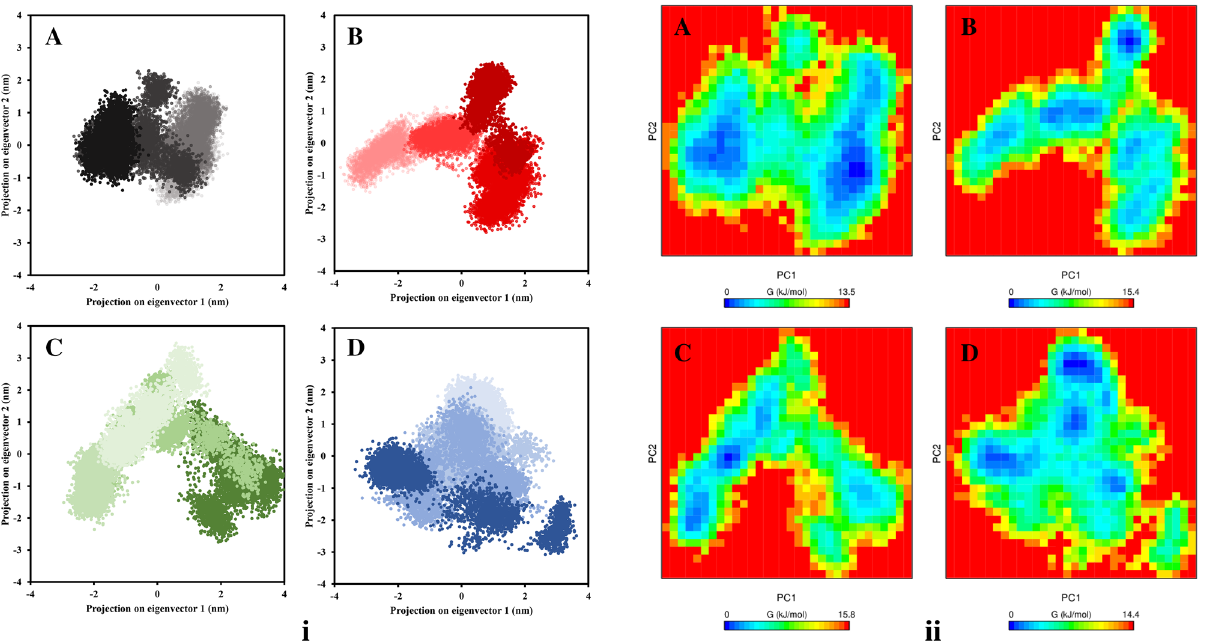
Figure 3. (i) Principal component analysis (PCA) of unbound and bound SRCR5 forms: ( A ) unbound SRCR5 form (black dots), ( B ) SRCR5-brazilin complex (red dots), ( C ) SRCR5-catechin complex (green dot) and ( D ) SRCR5-epicatechin complex (blue dots). (ii) The free energy landscape (FEL) of unbound and bound forms of the SRCR5 receptor: ( A ) unbound SRCR5 form, ( B ) SRCR5-brazilin complex, ( C ) SRCR5-catechin complex and ( D ) SRCR5-epicatechin